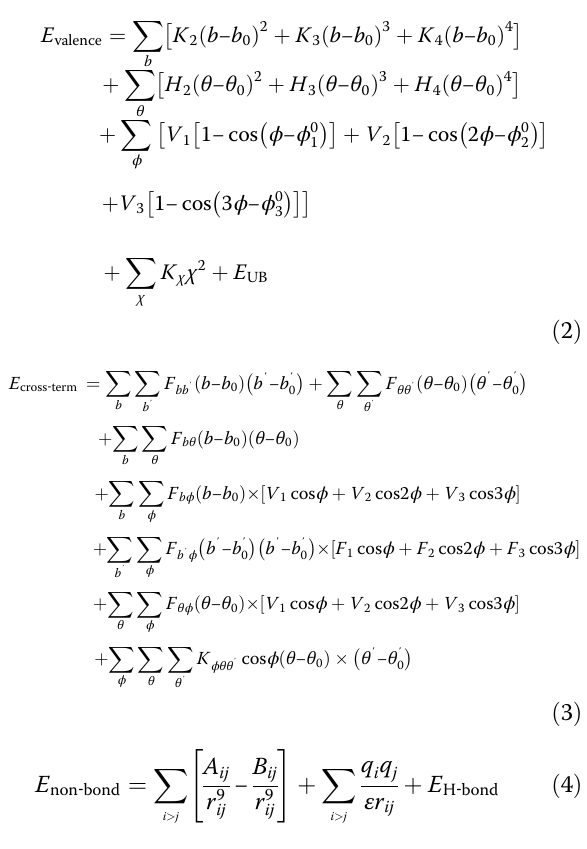
where b and b ′ are the bond lengths of two adjacent bonds, and θ , ϕ , and χ are the two-bond angle, dihedral torsion angle, and out-of-plane angle, respectively. q is the atomic charge, ε is the dielectric constant, r ij is the i -